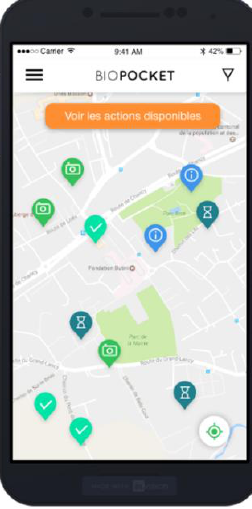
Figure 6. The interactive map in BioPocket application. Participants can check the type and location of actions, as well as the biodiversity points of interests around them .